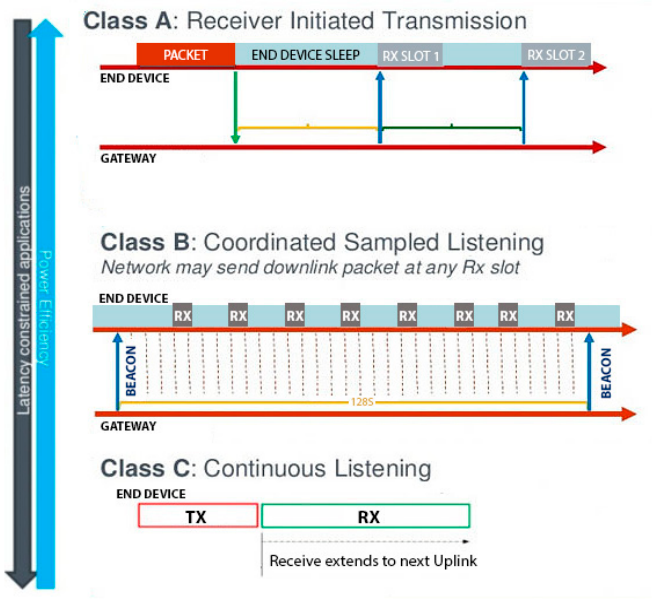
Figure 3. Operation of LoRaWAN classes .